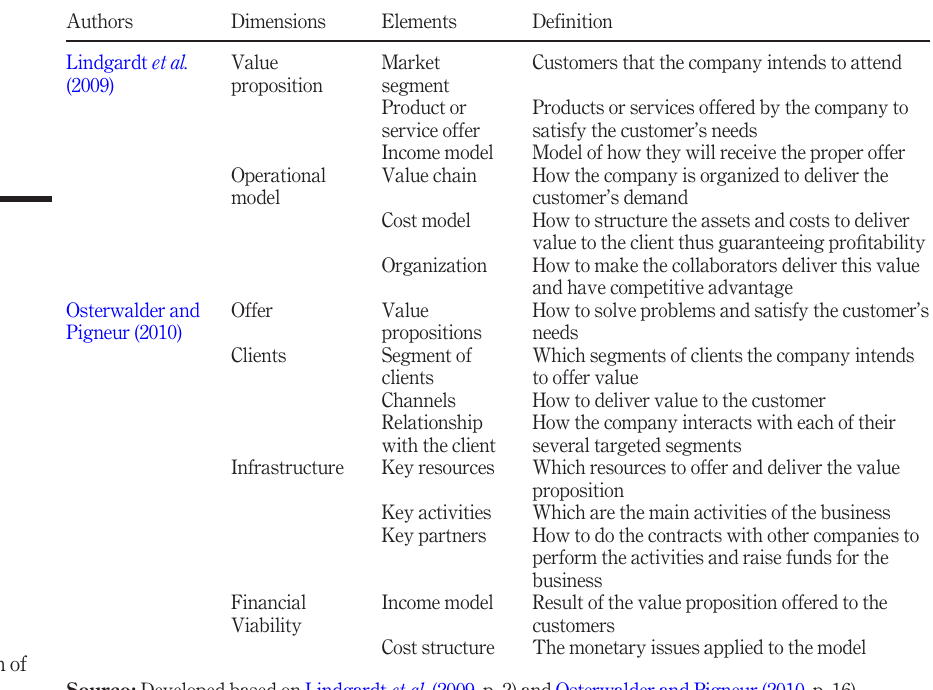
Table II. the Composition of